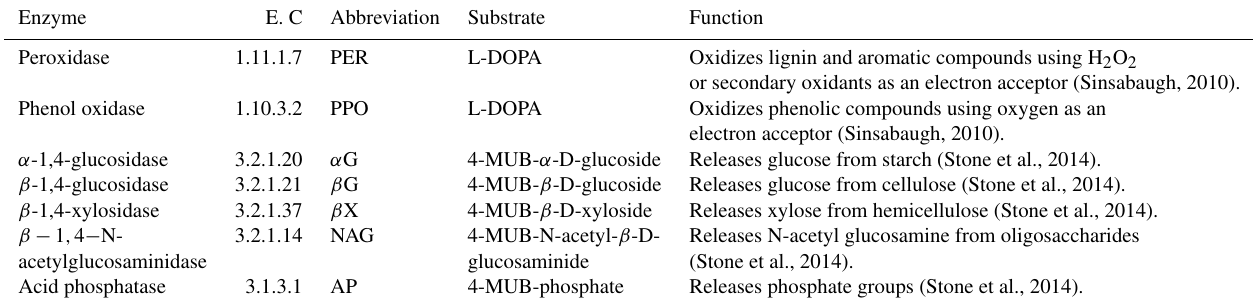
Table A1. Soil enzymes and their corresponding substrates and